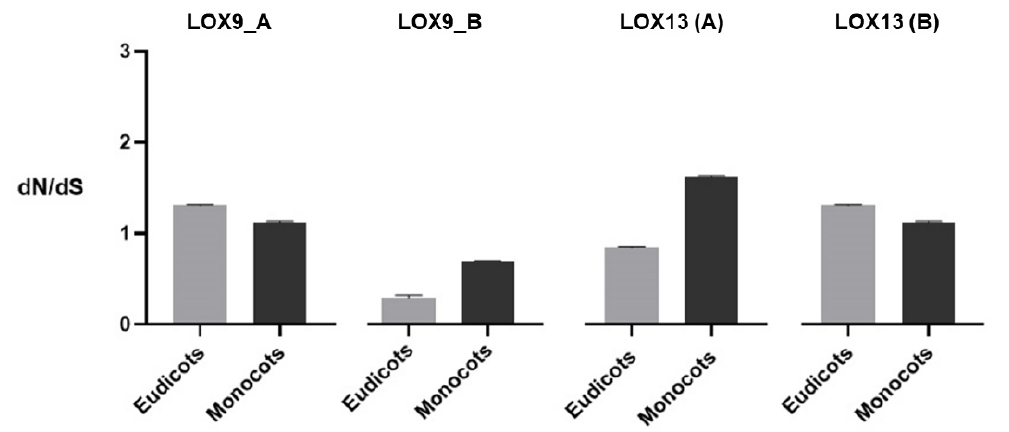
Figure 5. Comparison between the ratios of non-synonymous (dN) and synonymous (dS) substitutions between the LOX groups. Values obtained through the MEGAX program. Calculations performed on the Datamonkey platform ( p < 0.05) using models of positive selections and dN/dS replacement ratios of LOX genes in eudicots and monocots.